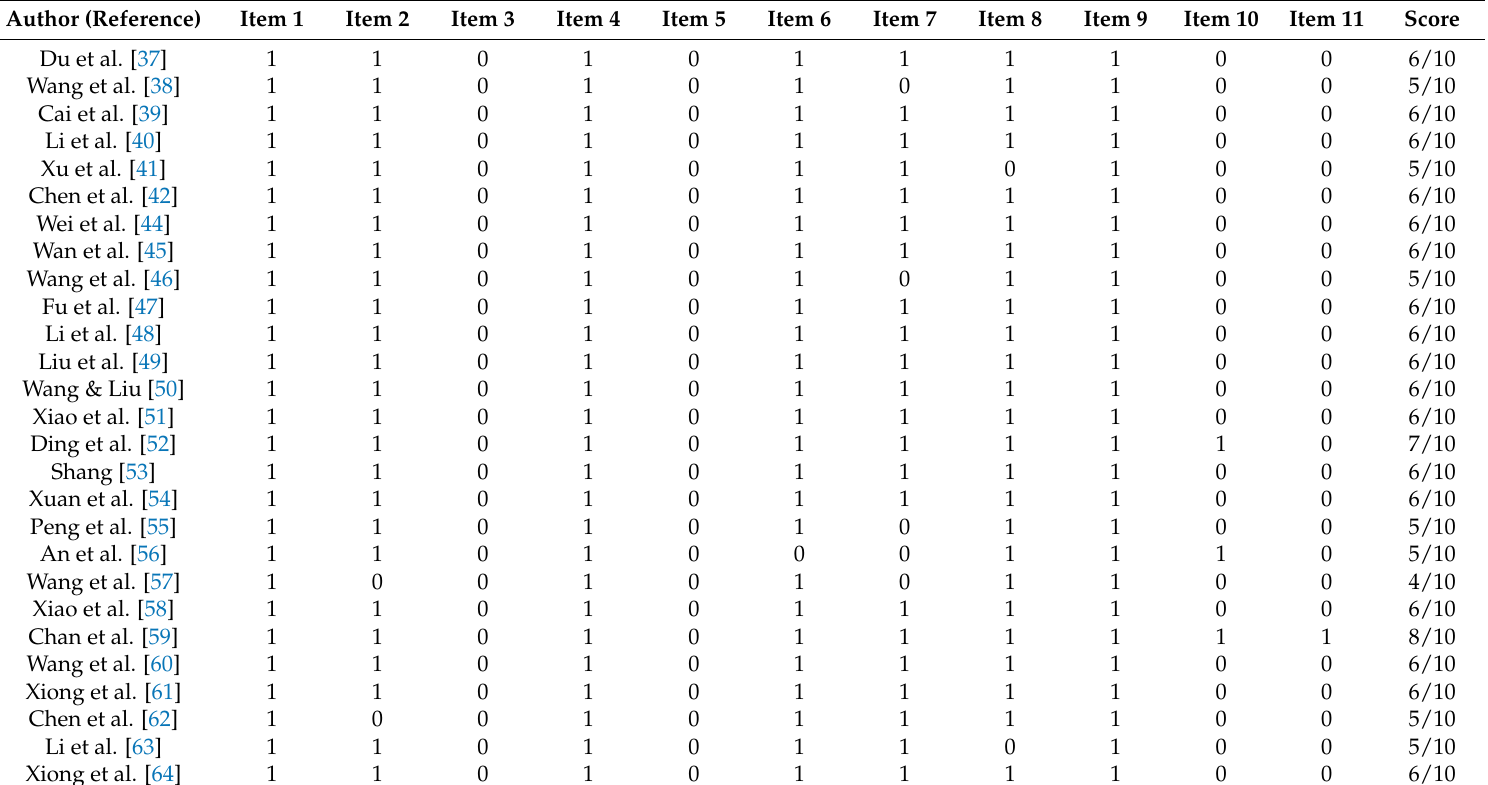
Table 2. Methodological quality for randomized controlled trials and non-randomized controlled